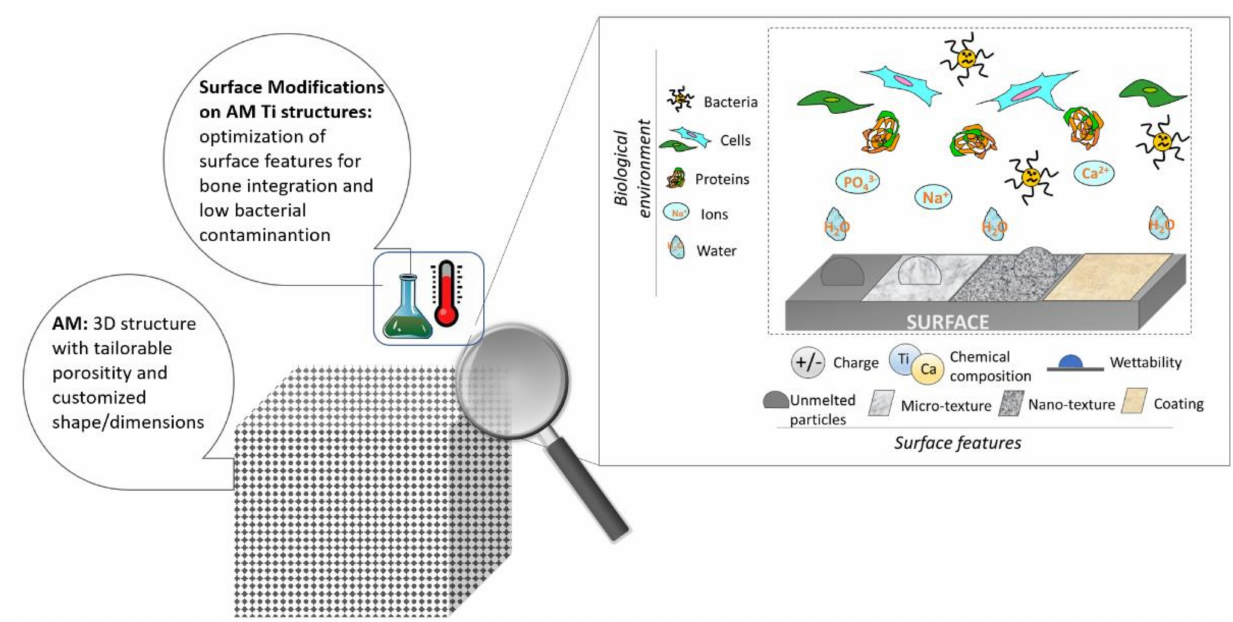
Figure 1. Scheme of the idea beyond the combination of additive manufacturing and surface modifications.